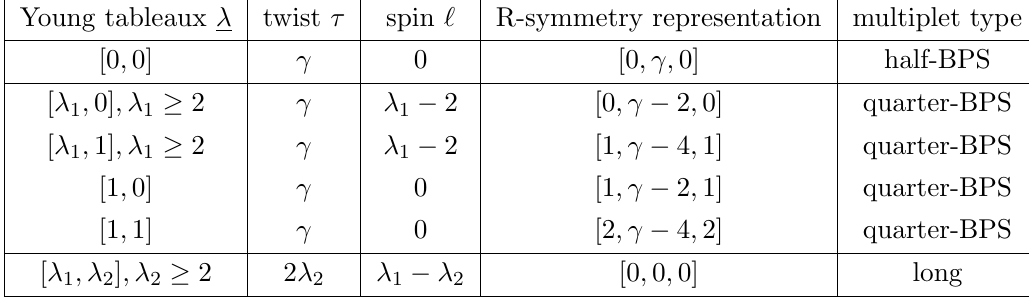
Table 1 . Supermultiplets appearing in the superconformal partial waves of hO 20 0 O 20 0 O 20 0 O 20 0 i